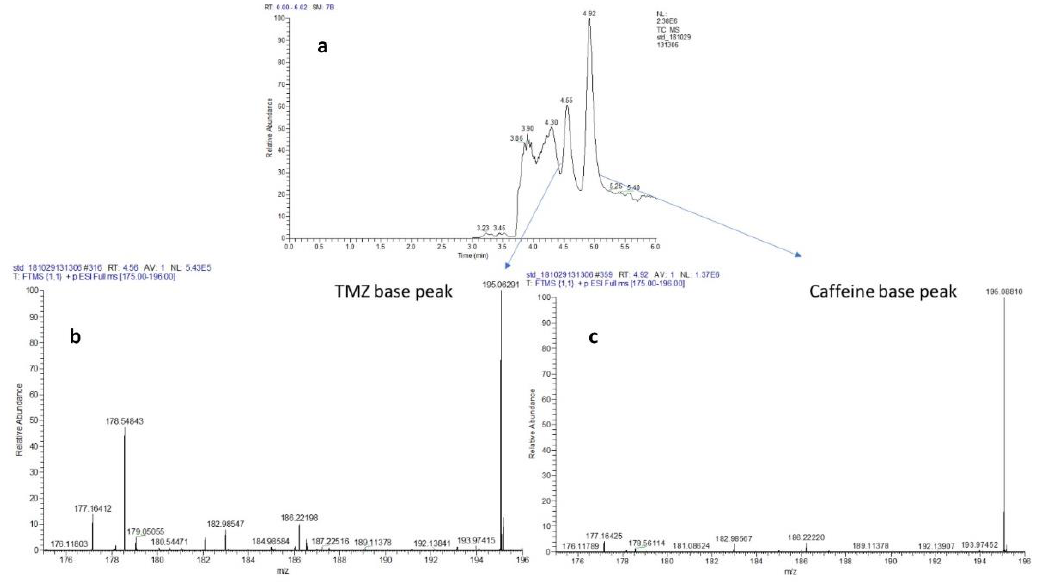
Figure 4. ( a , b ) Extracted ion chromatogram (XIC) of TMZ with and without caffeine 30:70 (Water 0.1% FA: ACN 0.1% FA) in the plasma sample. ( c ) The simultaneous injection and separation XIC of TMZ and caffeine (caff).